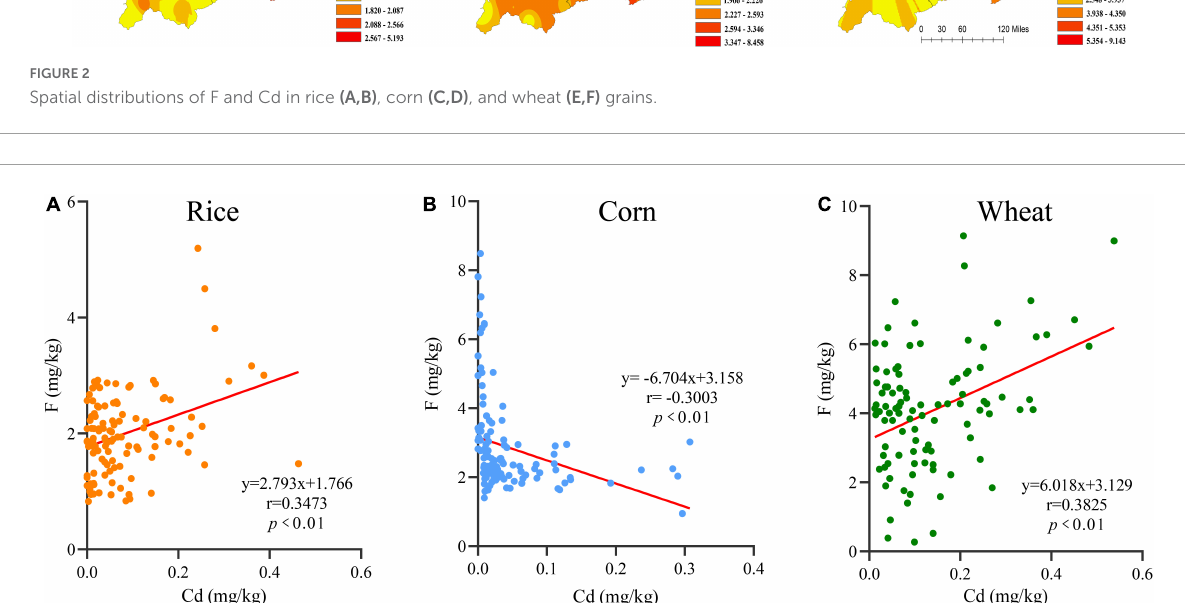
FIGURE3 The linear relationships of F and Cd in rice (A) , corn (B) , and wheat (C) grains.